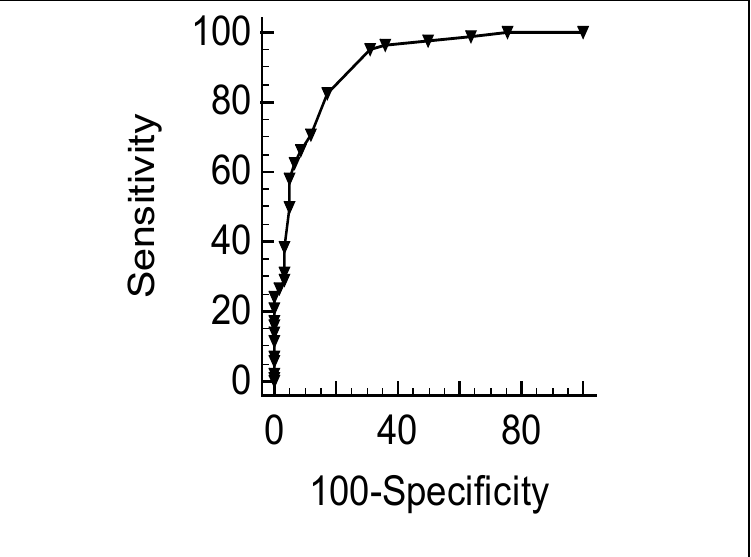
Figure 1. ROC curve plotting MTX intolerance with the questionnaire against the gold standard with cut-off scores of 5, including JIA and relative responses. AUC = 0.90 (95% CI, 0.85–0.94).